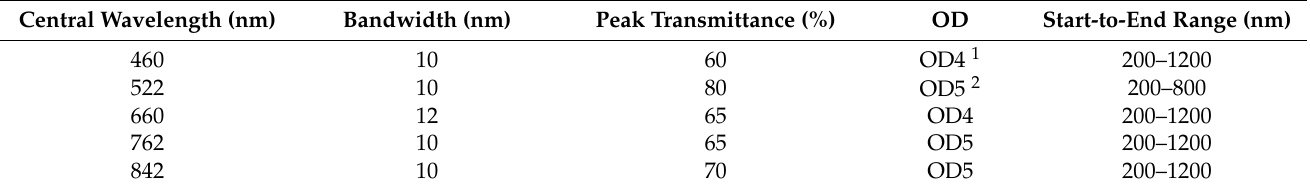
Figure 1. Multi-band image acquisition system: (1) near-infrared industrial camera, (2) C-mount lens, (3) optical filters, (4) ring light source with adjustable light intensity, (5) apple, (6) computer. Table 1. Parameters of the filters.